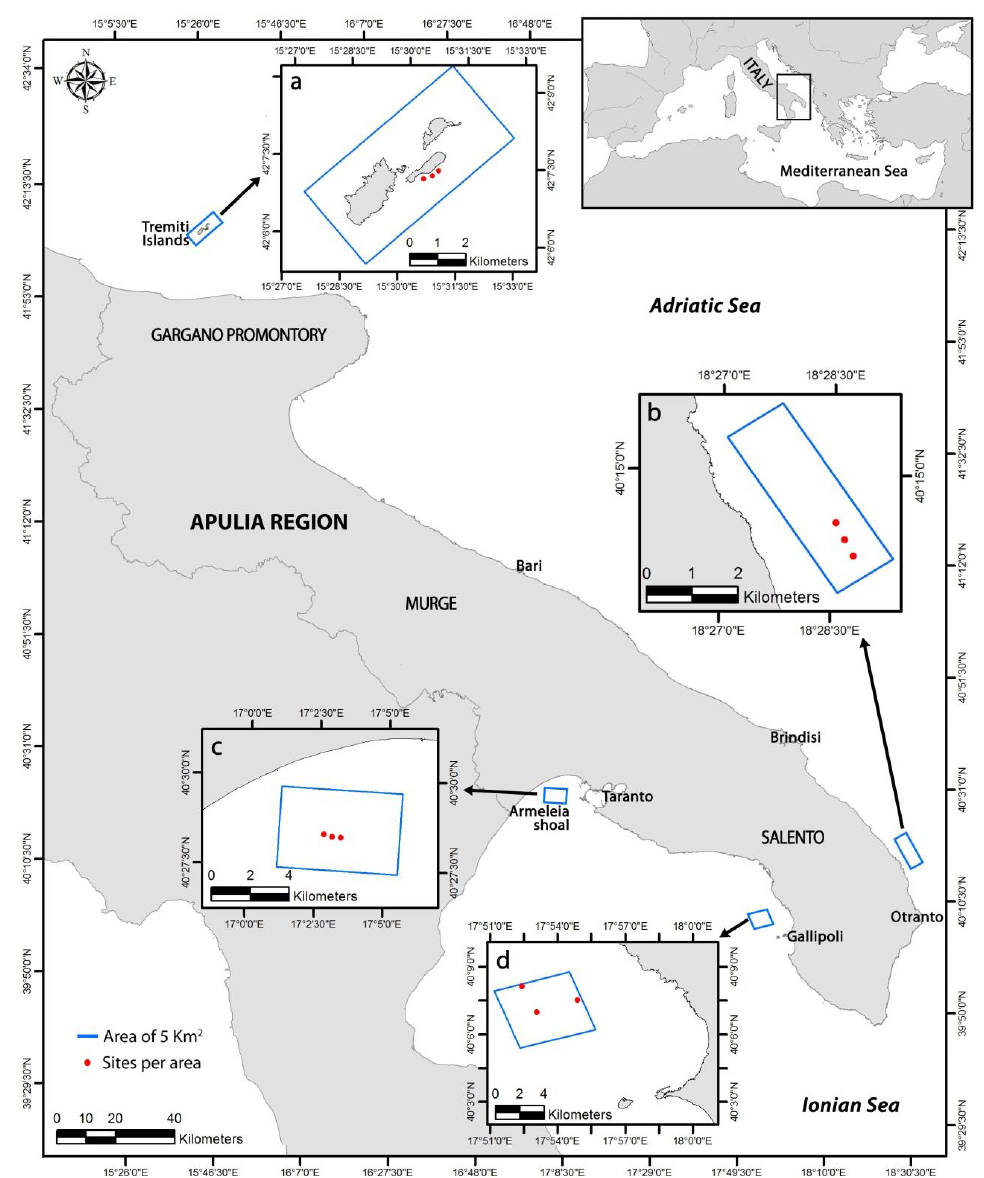
Figure 1. Map of Apulia Region. The four study areas are in blue: ( a ) Tremiti Islands Marine Protected Area (MPA); ( b ) northwest Otranto; ( c ) Armeleia shoal; ( d ) off Gallipoli. For each study area, three study sites (red dots) were selected for visual surveys and sampling.